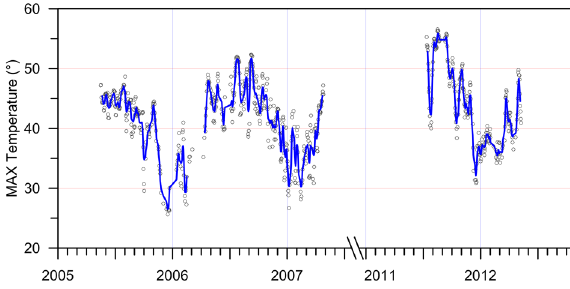
Figure 6. Chronograms of the maximum temperature of the whole scene. Circles and line represent one and two-pass 7 samples mov- ing averaged time series.